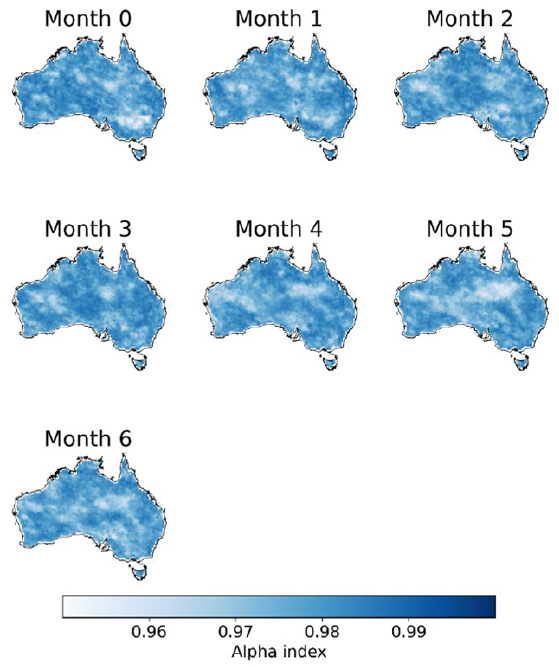
Figure 9. Alpha index of BJP-ti calibrated ensemble ET o forecasts.